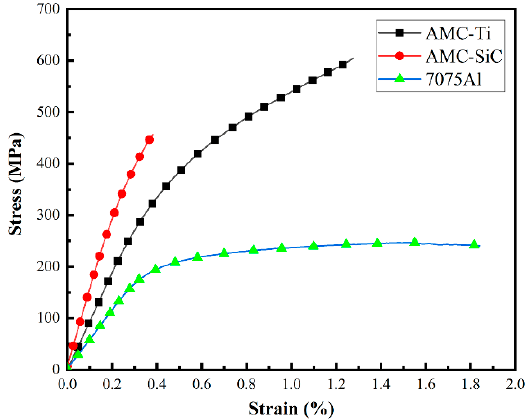
Figure 8. Phase diagram Ti–Al [26].